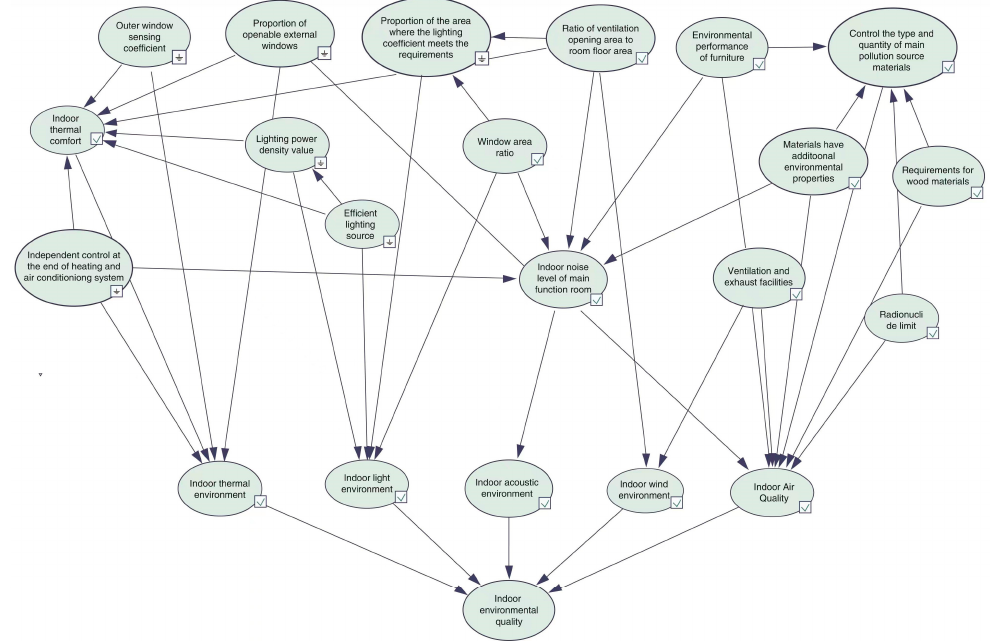
Figure 5. The Bayesian network structure of interior environmental quality assessment of building interior decoration.